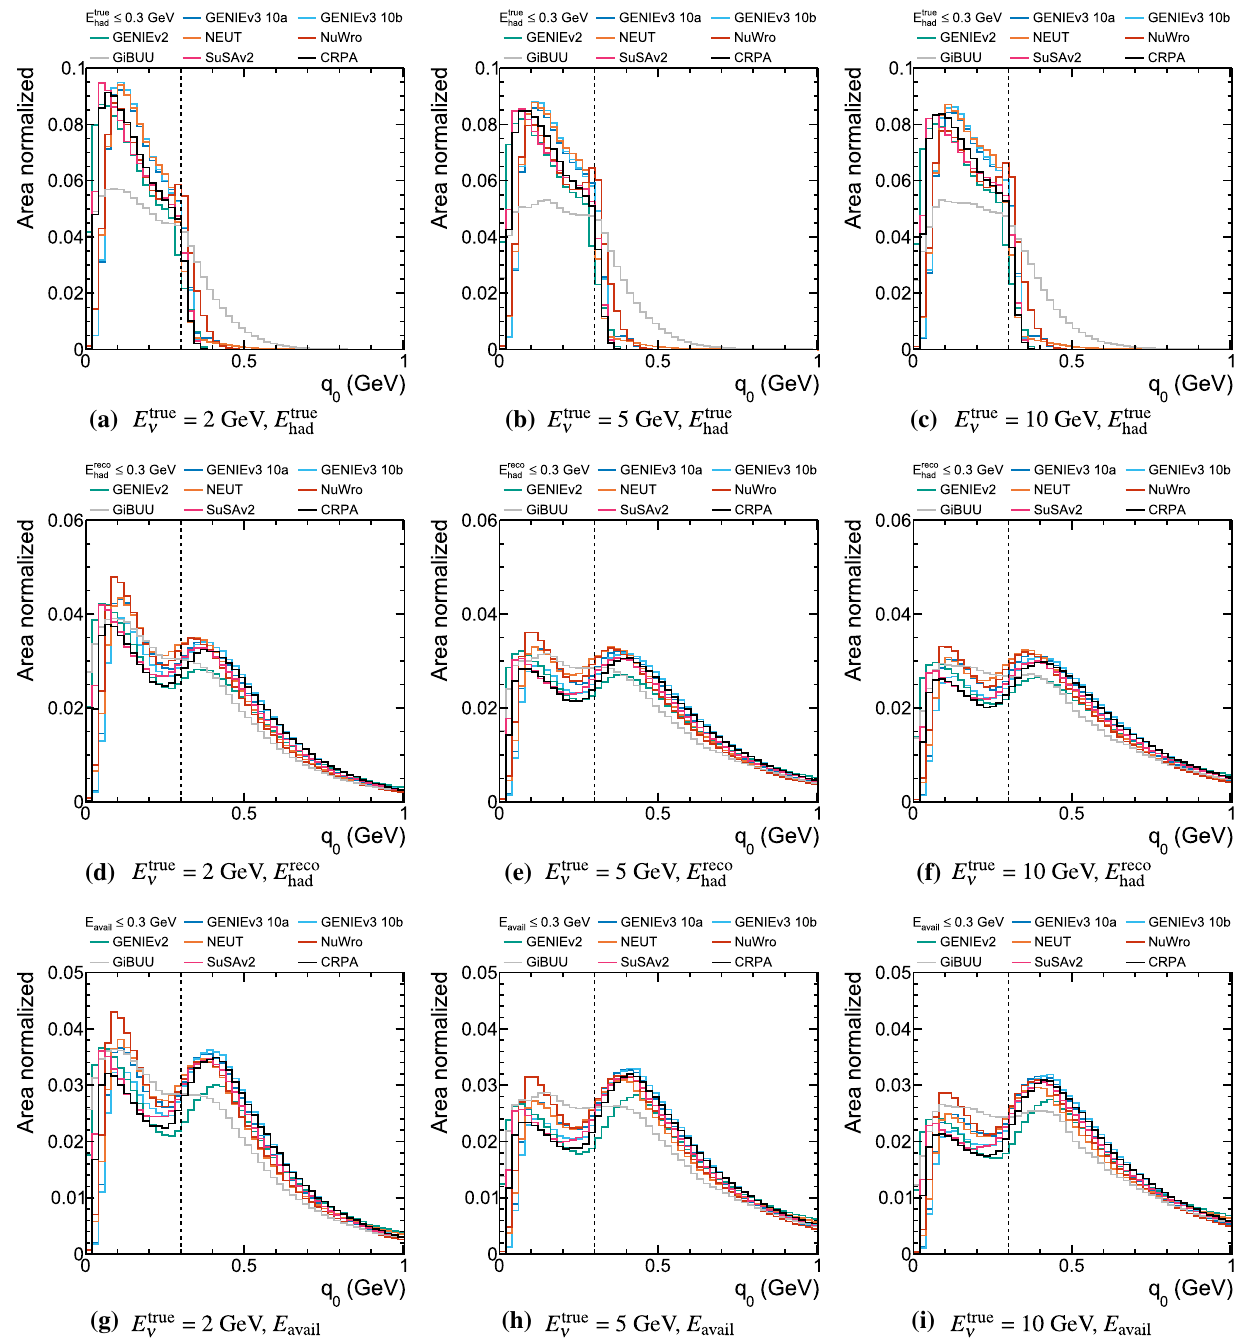
Fig. 7 The q 0 distributions for CC-inclusive ¯ ν μ – 40 Ar events which pass cuts on the three proxy variables which are experimentally observ- able: E true , E reco and E avail ≤ 0.3 GeV, shown for all the generators had had